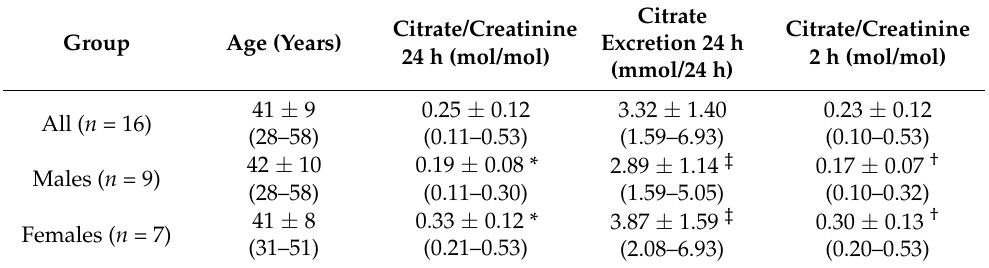
Table 5. Urinary citrate concentration in real samples from healthy